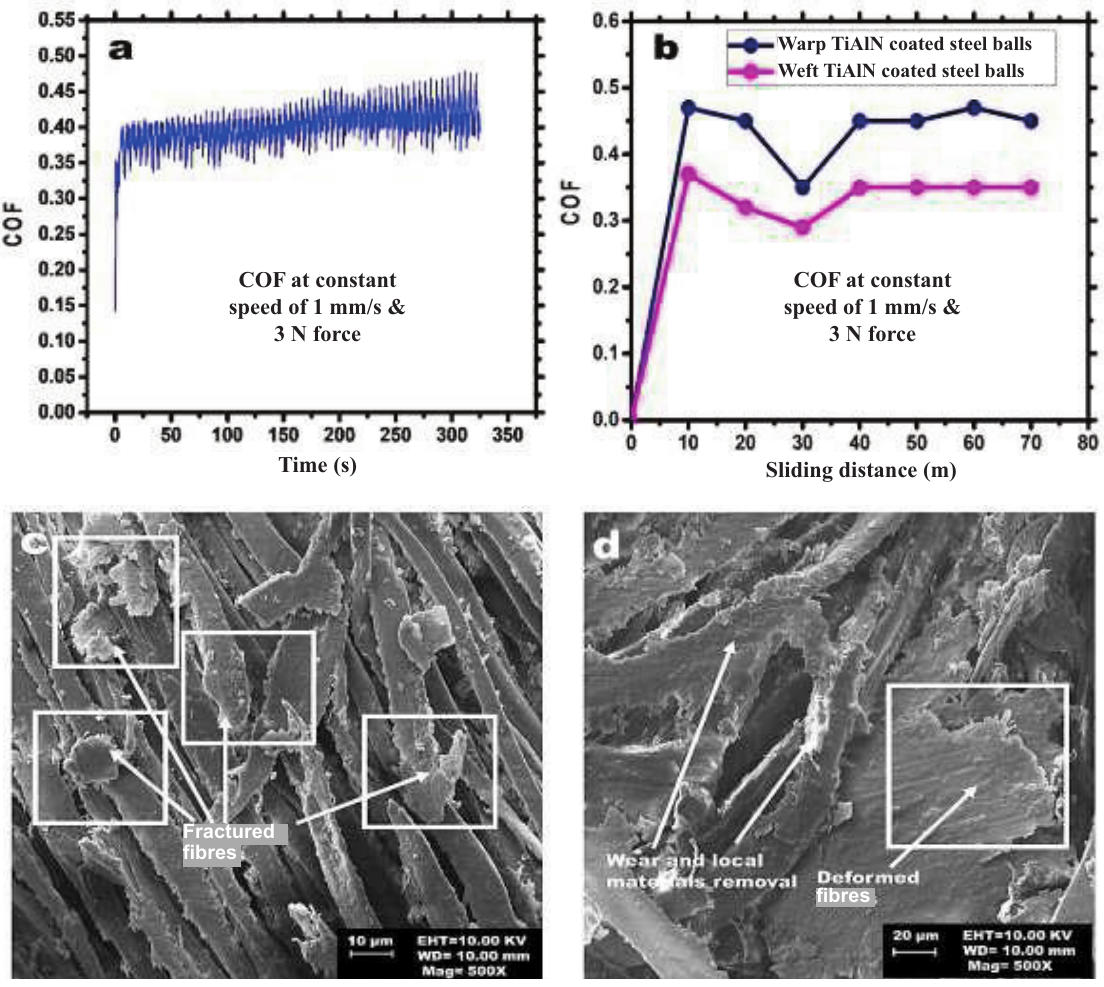
Fig. 6. (a) COF versus time variations, (b) COF versus sliding distance observations, (c) SEM image of weft fibresʼ fracture, (d) SEM image of warp fibresʼ fracture.